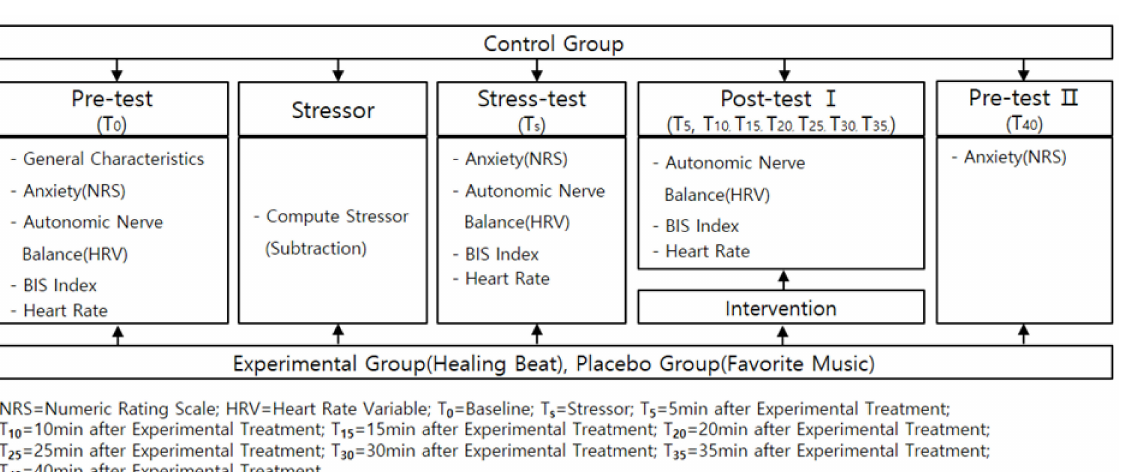
Figure 1. Research